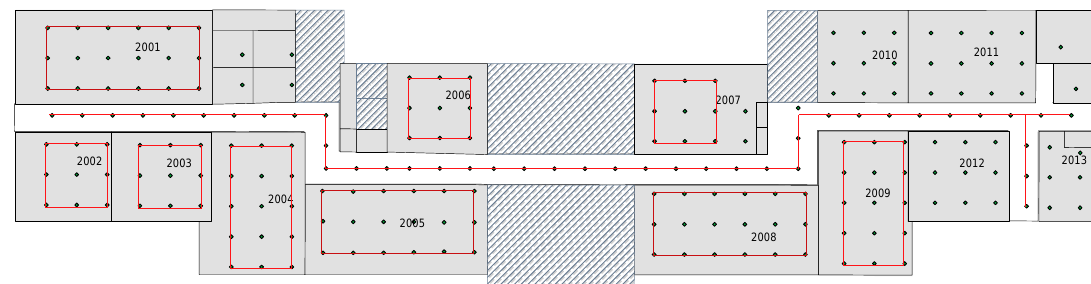
Figure 12. Our Wi-Fi fingerprinting experimental testbed—all the training locations (reference points) are marked as dark green points, and the office rooms are marked as the gray area. It is noted that the areas in shadow are unavailable locations. The red curves denote the predefined paths (starting from room 2005), which are designed along the reference points to ease the